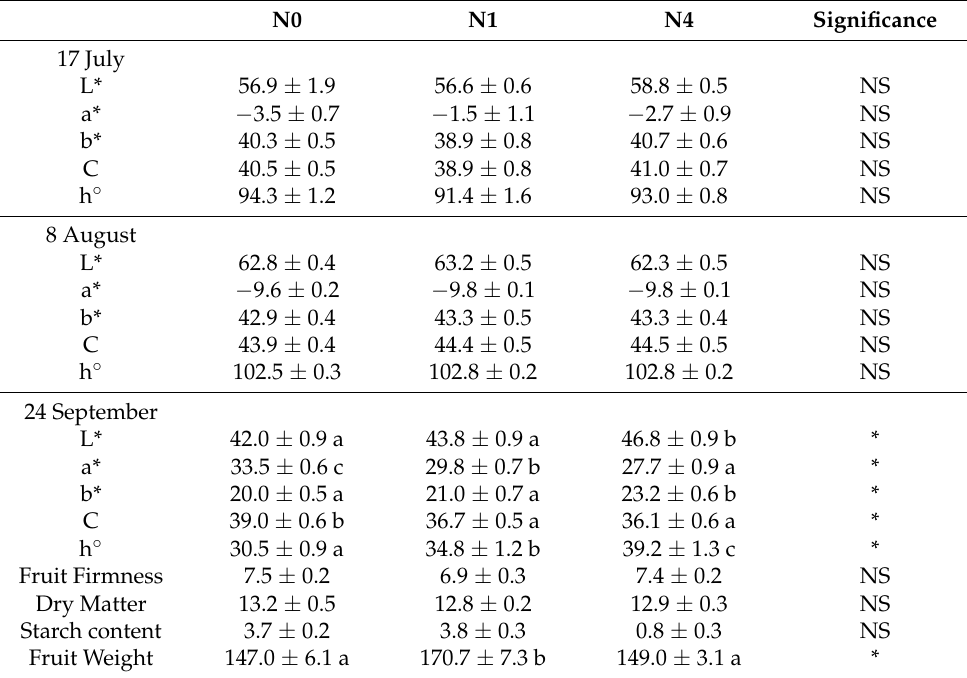
Table 1. Fruit weight (g), flesh firmness (kg per cm 2 ), dry matter ( ◦ Bx), and starch content (visual scale 0–5) at harvest and color parameters of ‘Topaz’ apples during the experimental period subject to three urea treatments. N0 N1 N4 Significance